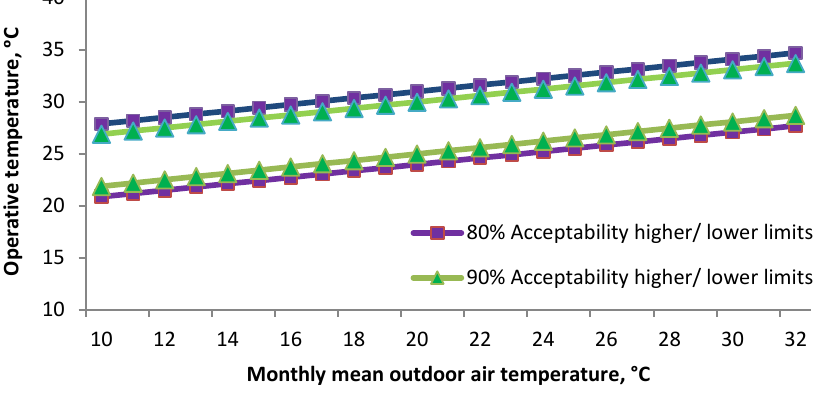
Fig. 1. The 90 % and 80 % acceptability limits for indoor operative